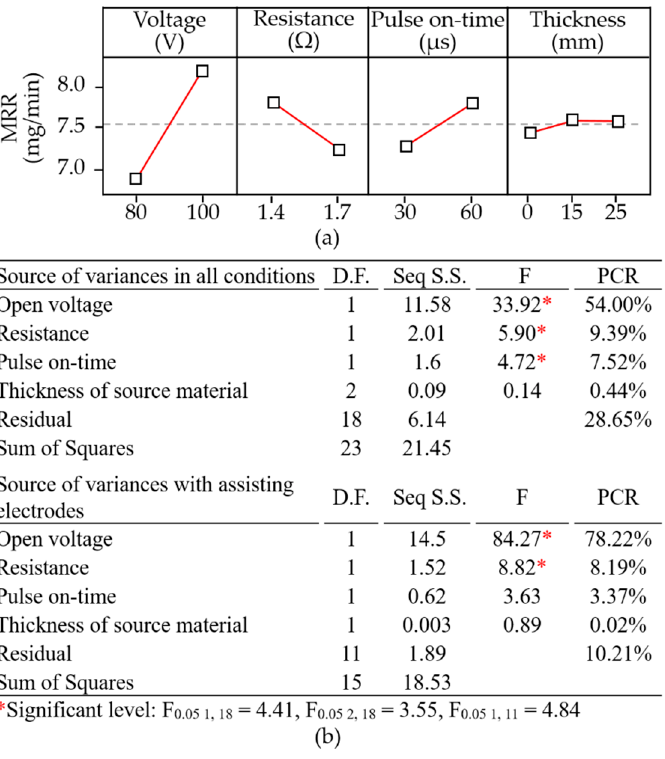
Figure 12. Statistical examination of main effect plots: ( a ) with operating parameter set- tings; ( b ) ANOVA results pertaining to material removal